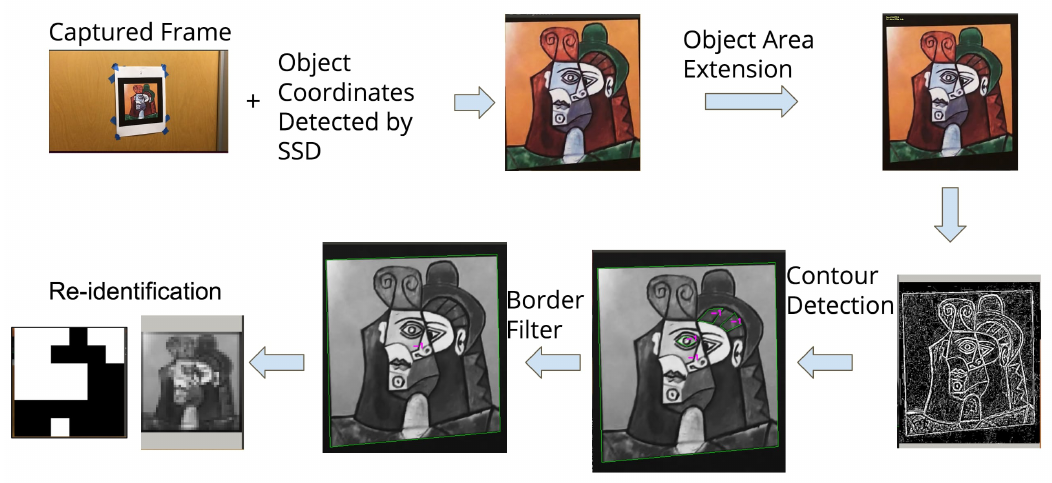
Figure 8. Corner Points